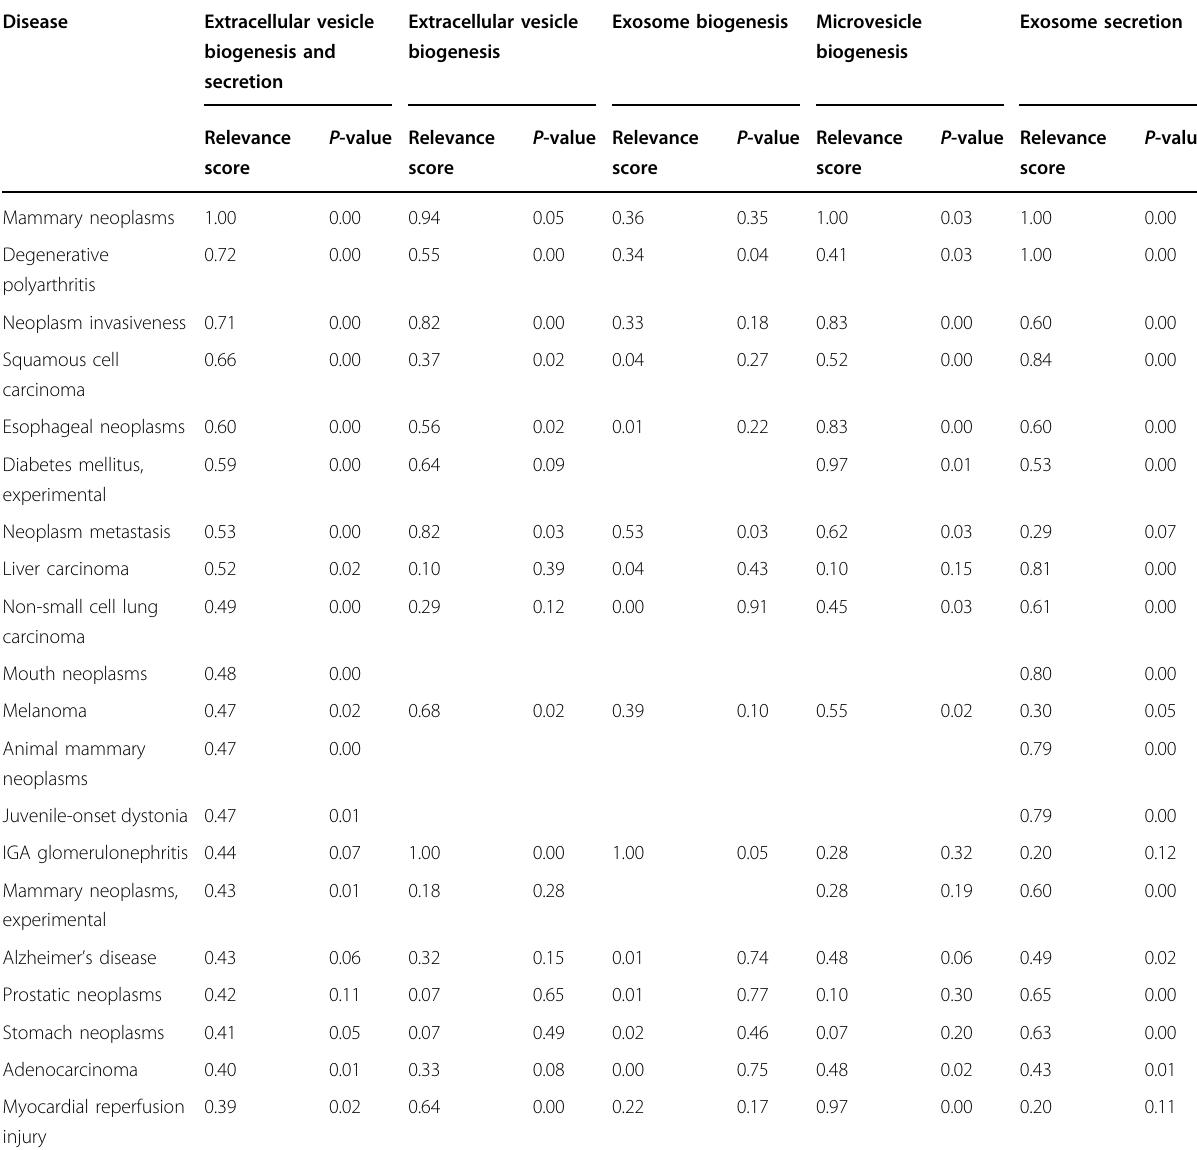
Table 4 Diseases associated with different sets of key EV genes based on gene-disease associations known in the literature